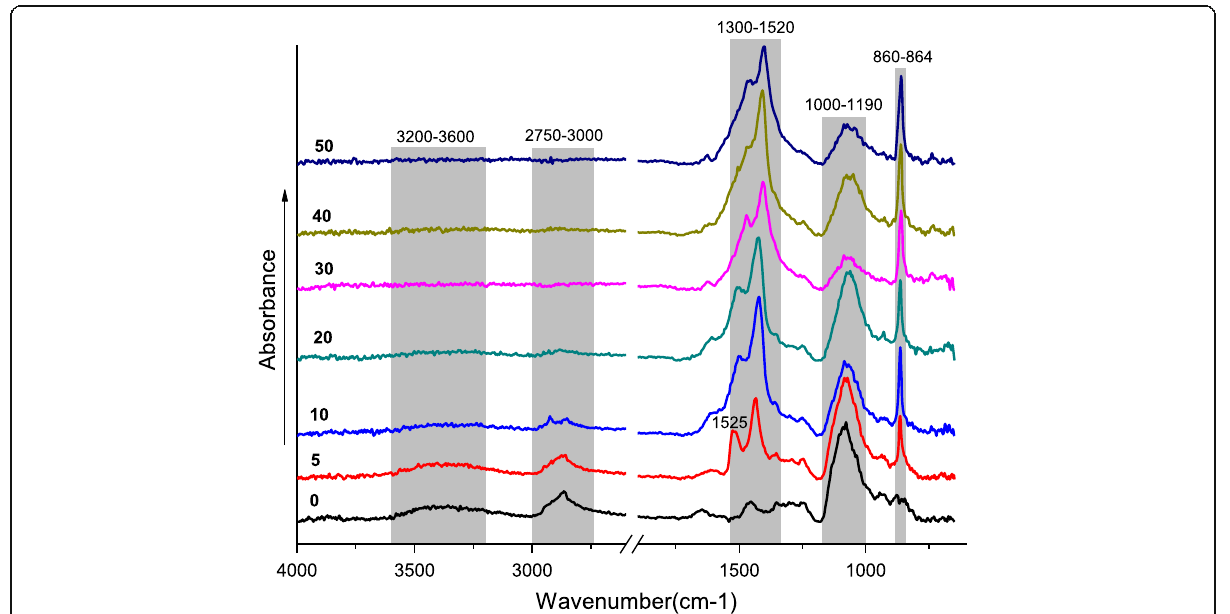
Fig. 3 The IR spectra of the composites. The infrared spectroscopy of the systems with the different lithium perchlorate salt content (the numbers near curves)